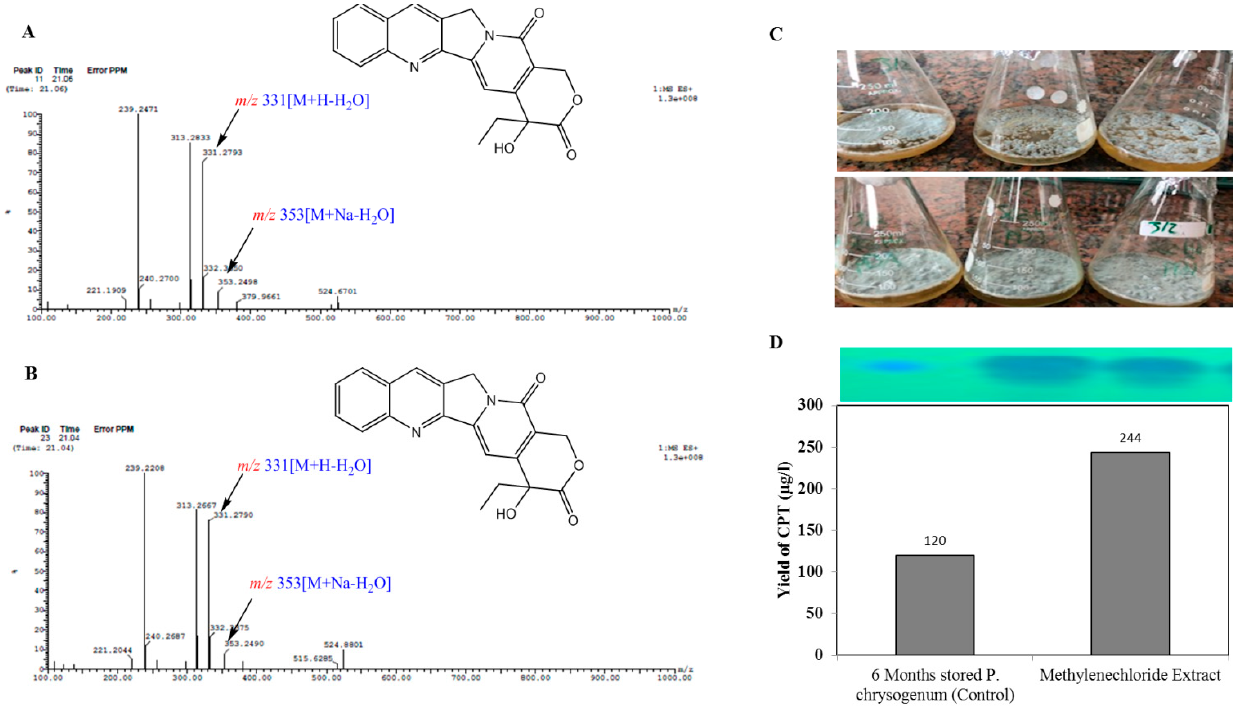
Figure 7. Restoring the biosynthetic potency of camptothecin of the 6-month stored P. chrysogenum upon addition of methylene chloride of Cliona sp. The 6-month stored P. chrysogenum was grown on the optimized medium, and methylene chloride extracts of Cliona sp. were amended to the culture after 5 days of incubation under standard conditions, then camptothecin was extracted and checked by LC-MS/MS. The LC-MS/MS pattern of extracted camptothecin from the control culture of P. chrysogenum (6-months) ( A ) and culture amended with methylene chloride extracts of Cliona sp. ( B ). ( C ) Morphological features showing conidial pigmentation of control culture (upper panel) and amended with methylene chloride extracts of Cliona sp. (lower panel). ( D ) Yield of camptothecin from the cultures of P. chrysogenum as determined by HPLC.